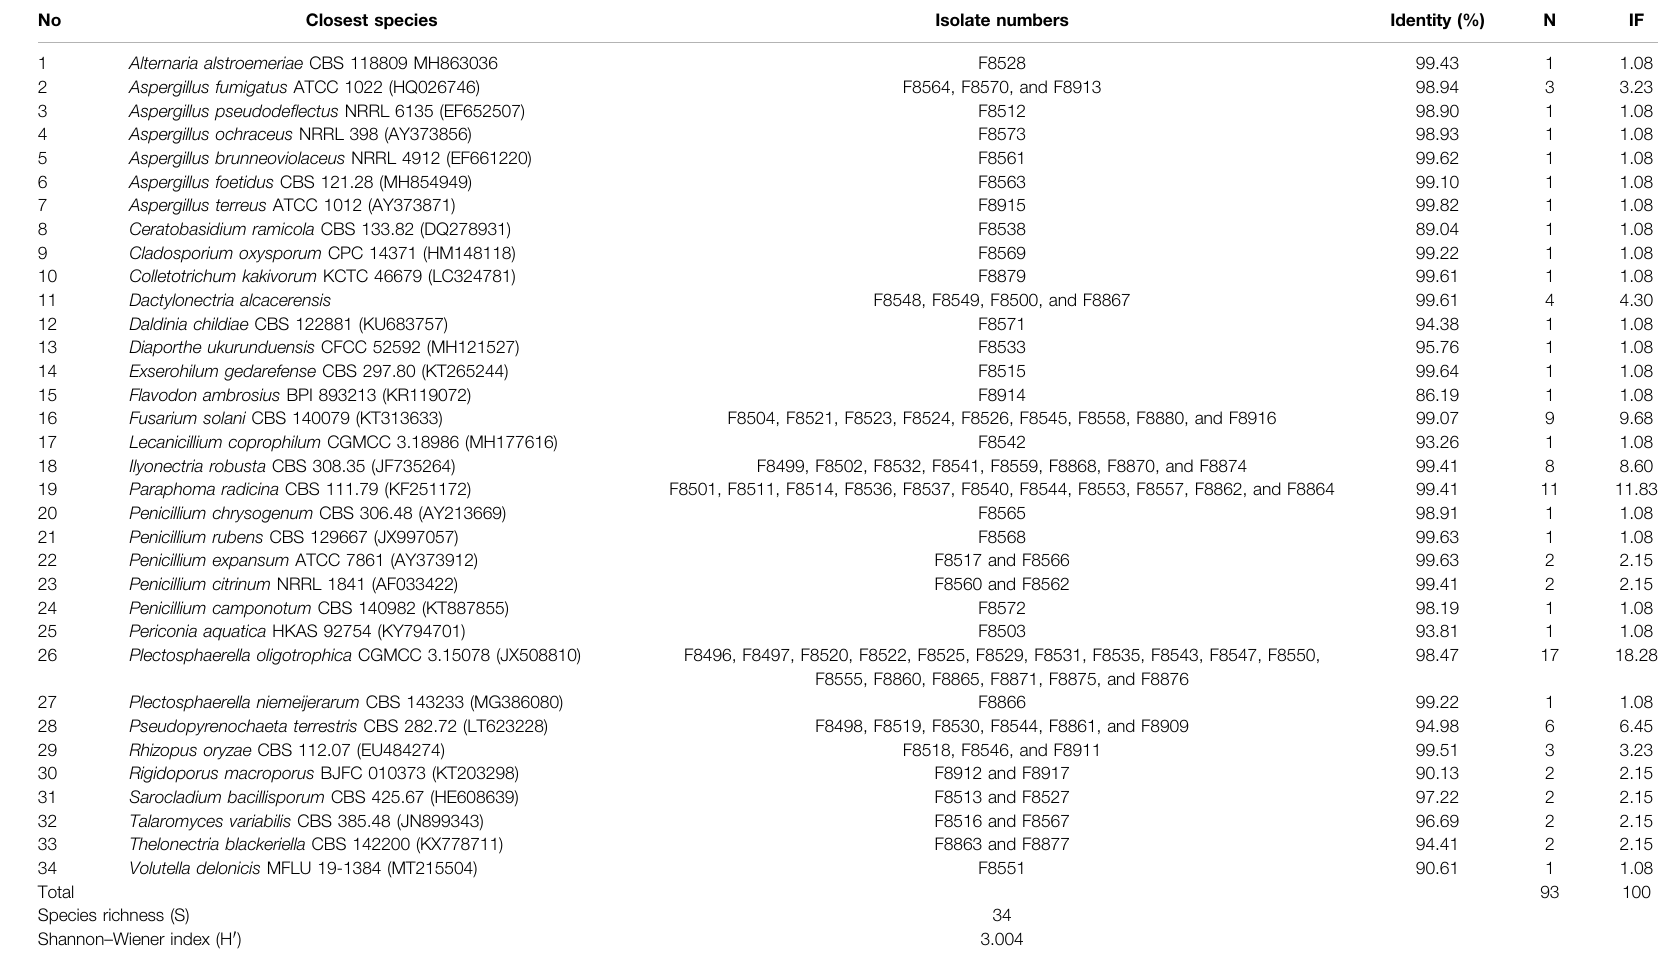
TABLE 1 | Identi fi cation of endophytic fungi from P. bipinnati fi dus by the Basic Local Alignment Search Tool (BLAST) in the GenBank database. No Closest species Isolate numbers Identity